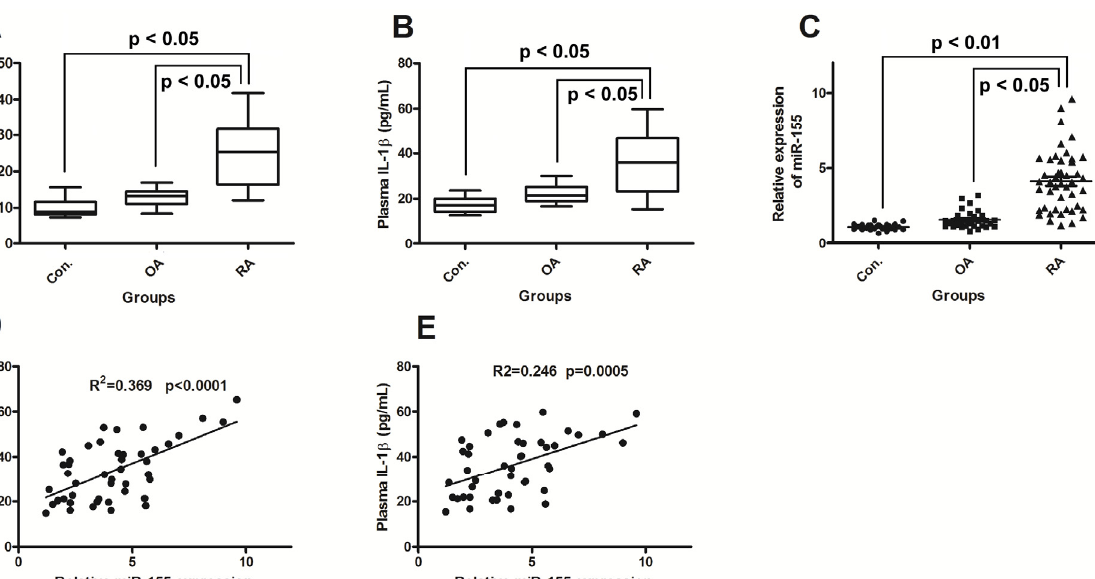
considered with a p value <